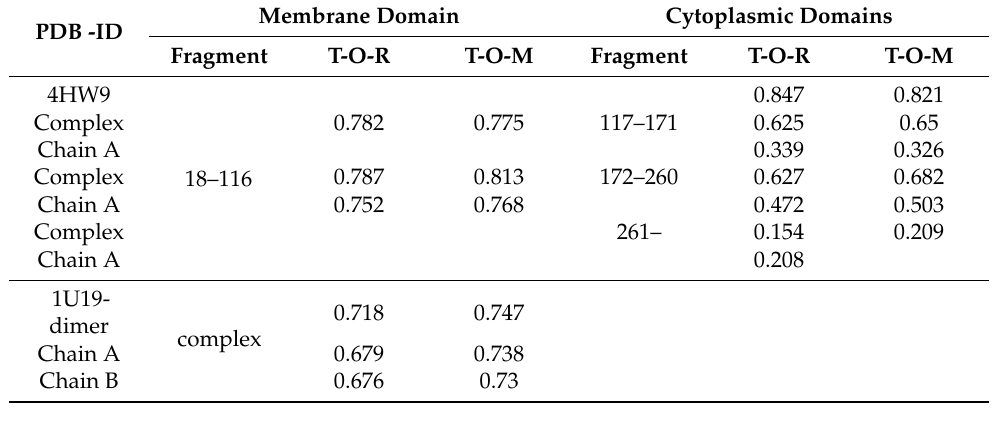
Table 2. RD values for discussed proteins. The relation T-O-R and T-O-M are presented for complex